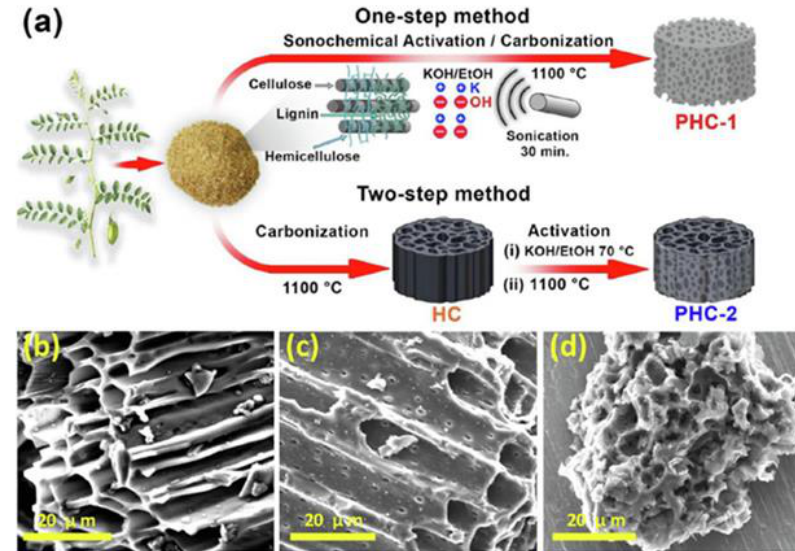
Figure 6. ( a ) Schematic illustration of both one-step sonochemical and two-step conventional synthesis of activated carbons. SEM images of ( b ) hard carbon (HC, nongraphitizable), ( c ) a conventional two-step activated sample (PHC-2), and ( d ) a sonochemical one-step activated sample (PHC-1) [77]. Reproduced with permission from ref. [77]. Copyright 2021, Elsevier Inc.